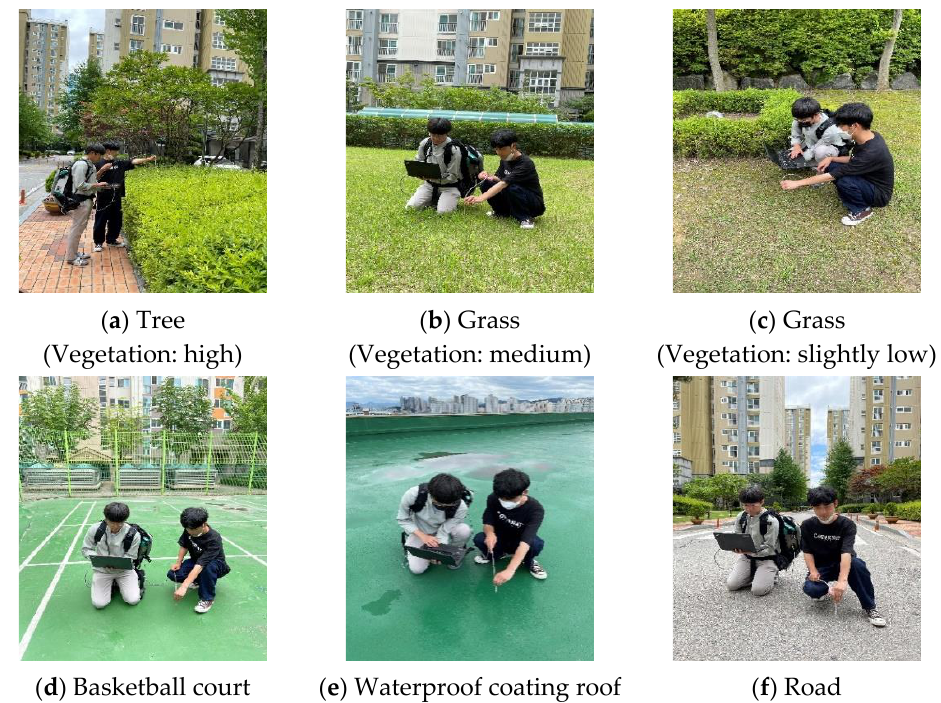
Figure 9. Investigation of reflectance by wavelength using ASD FieldSpec4 spectrometer.